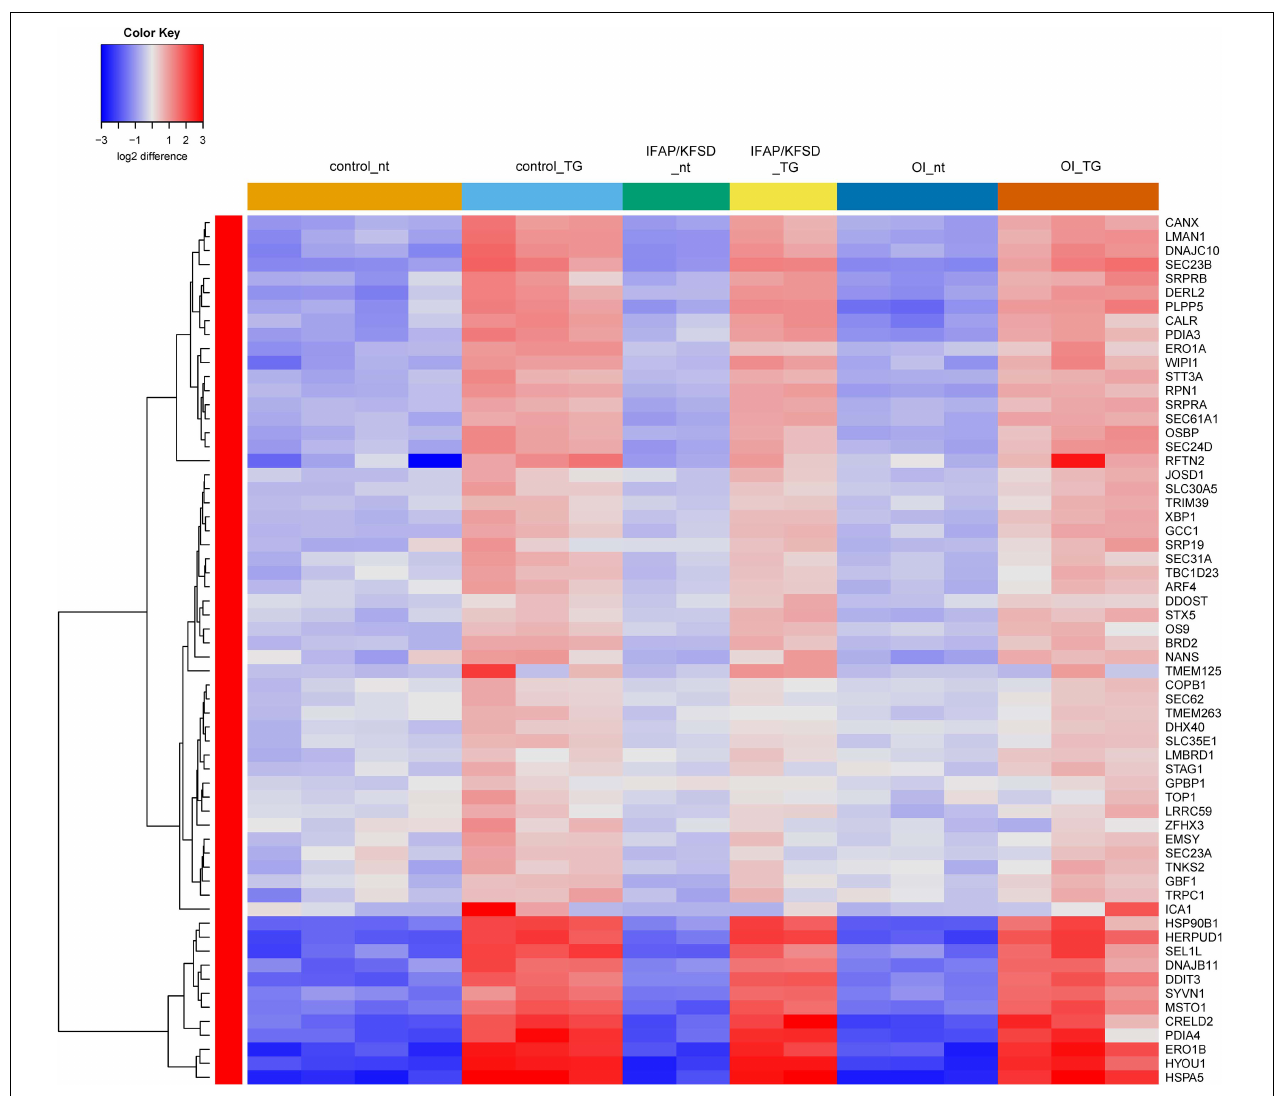
FIGURE 3 | Heatmap depicting expression levels of genes that are transcriptionally regulated by ATF6 at basal conditions (nt: no treatment) and in the presence of thapsigargin (TG). The dendrogram on the left y-axis shows clustering of the genes.